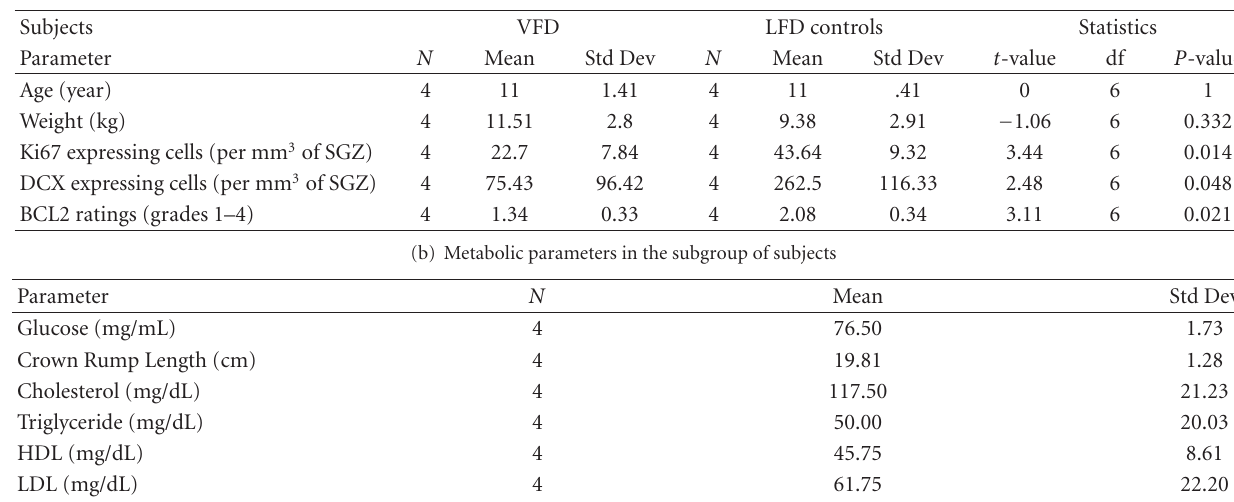
Table 1: Descriptive statistics of study variables.